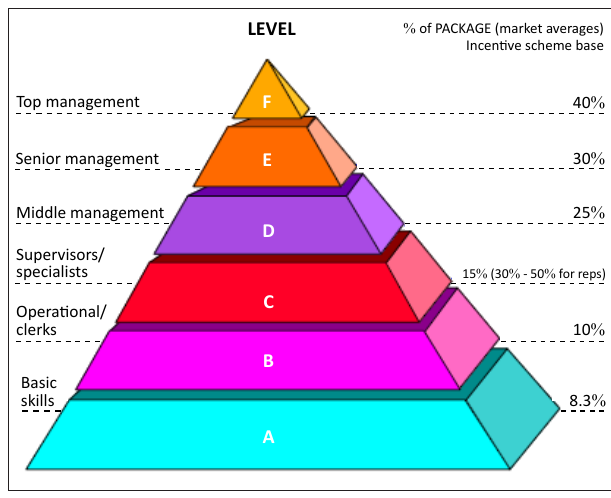
FIGURE 2: Incentive payouts – market